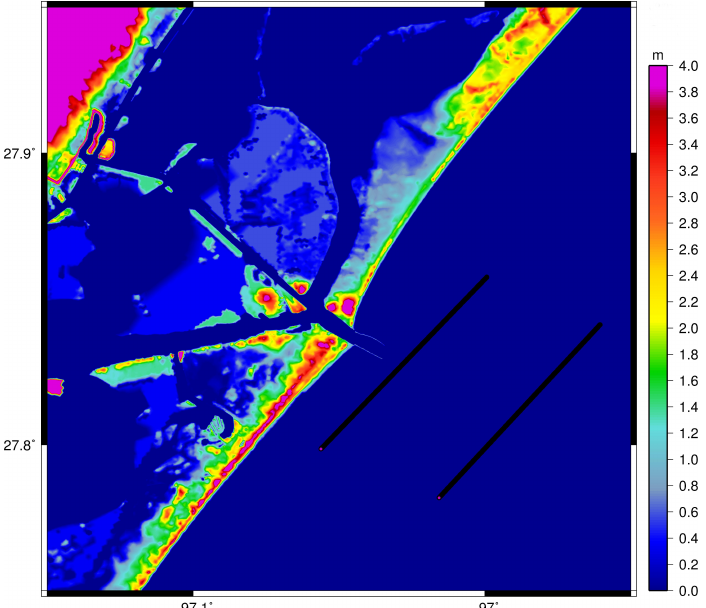
Figure 10. Initial condition III-2386 particles uniformly distributed outside Aransas Pass